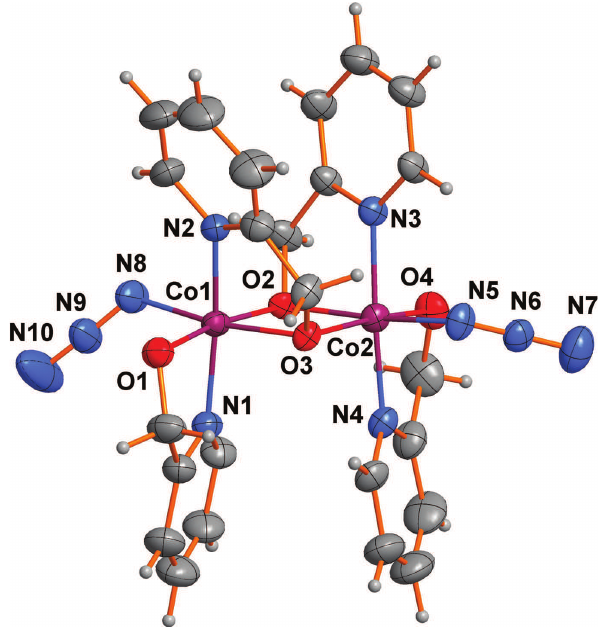
Table 1: Data collection and